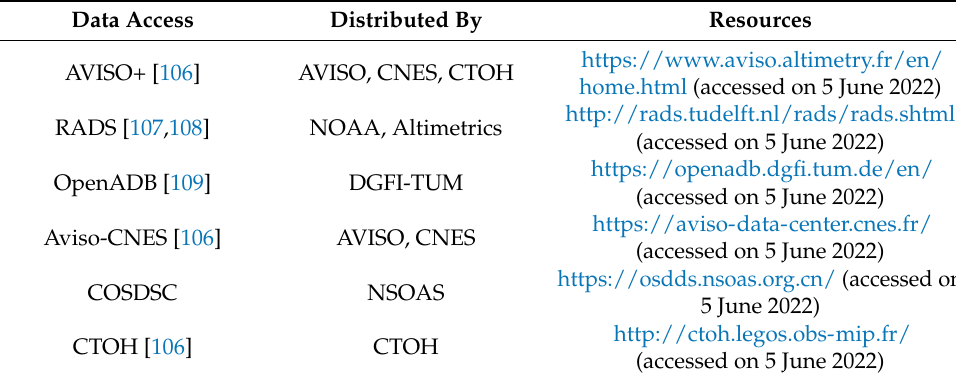
Table 2. List of available satellite altimetry data. Data Access Distributed By Resources AVISO+ [106] AVISO, CNES,